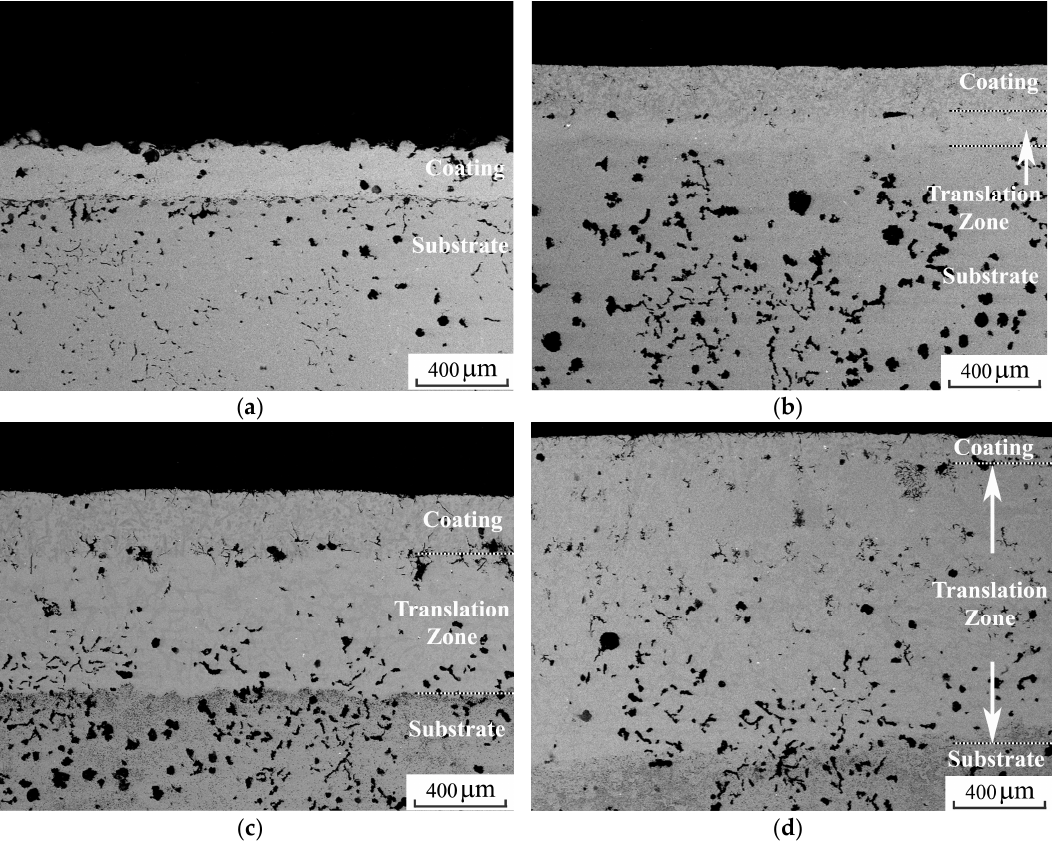
Figure 4. Cross-sectional microstructures of the coatings: ( a ) as-sprayed; vacuum annealed at ( b ) 990 °C; ( c ) 1020°C; ( d ) 1050 °C.